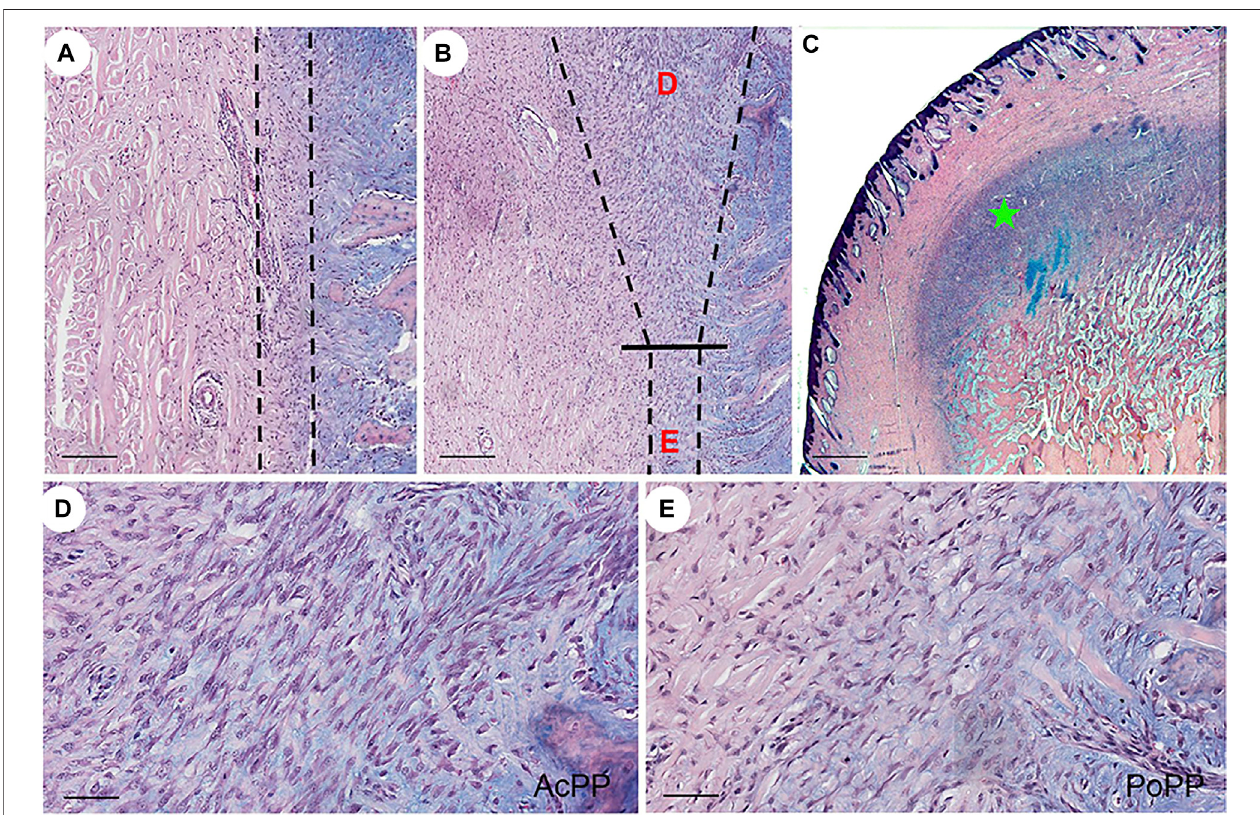
FIGURE 1 | Histological portrayal of PP differentiation during the initiation of antler regeneration. Histological sections of the distal pedicle tissue after hard antler casting. (A) Dormant PP (DoPP) encompassed within the dotted lines. (B) Potentiated PP (PoPP, “ E ” ) and activated PP (AcPP; “ D ” ) within the dotted lines. (C) AcPP ( “ green star ” ). HE and Alcian blue staining. (D,E) Higher magni fi cation of the areas “ D ” and “ E ” in (B) . It is to be noted that cells in the AcPP are much more densely populated than in the PoPP. Scale bar = 120 µm (A,B) , 1 mm (C) , and 50 µm (D,E) .